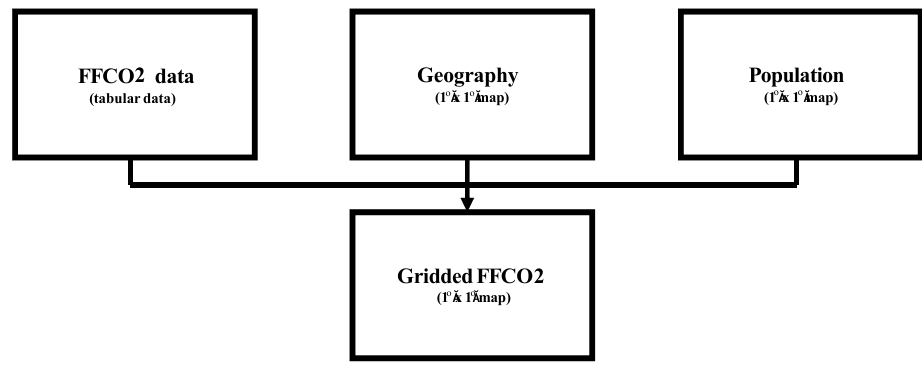
Figure 2. Basic CDIAC map creation process. The tabular FFCO2 emission data are mapped to regions of the world by the 1 ◦ latitude by 1 ◦ longitude (1 ◦ × 1 ◦ ) map of geography with within-country FFCO2 distribution provided by the 1 ◦ × 1 ◦ population distribution.